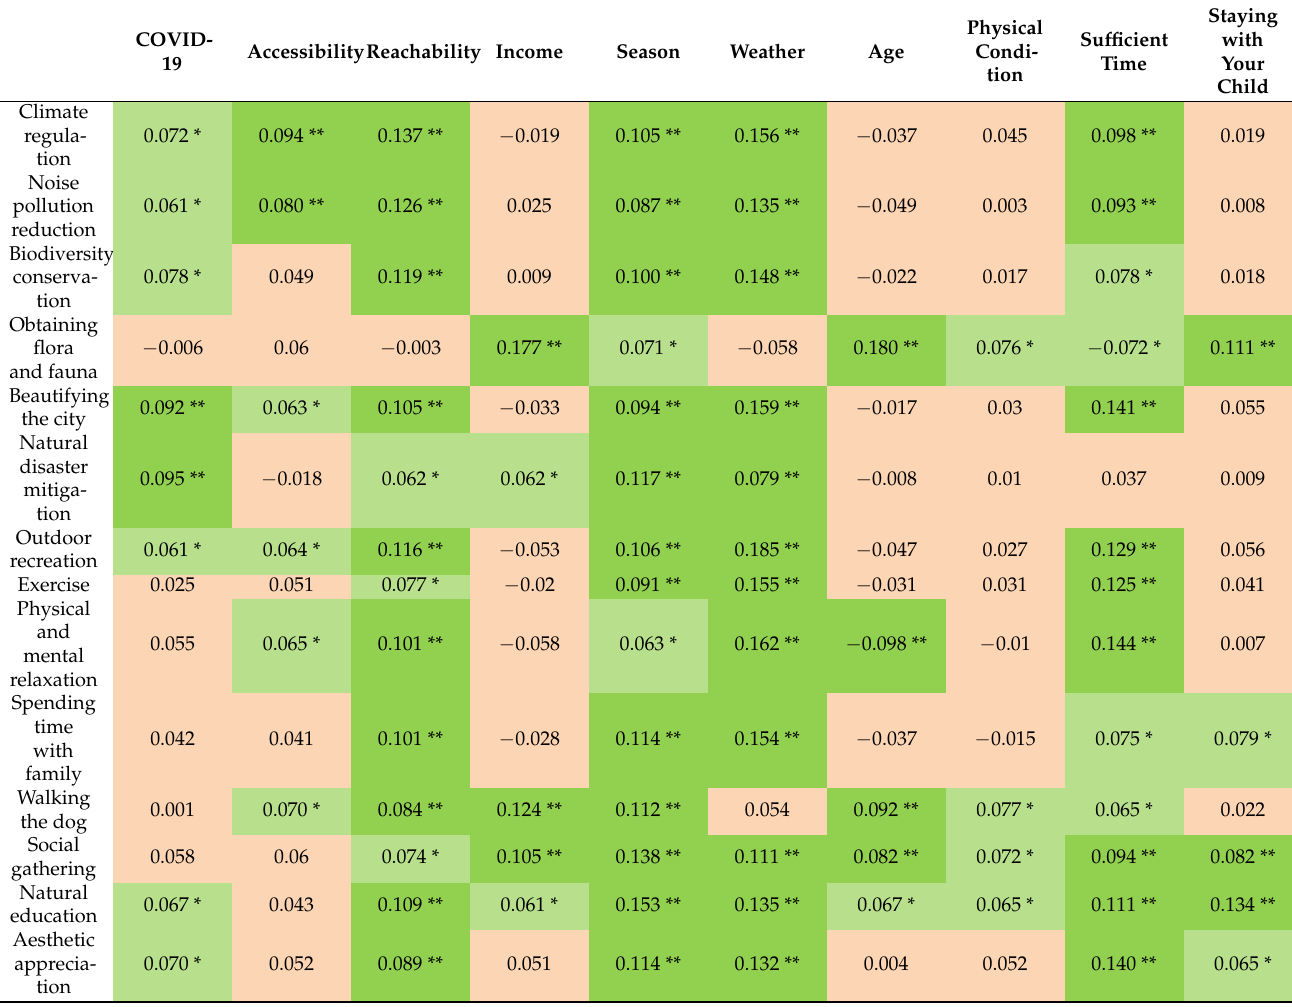
Table 3. Factors affecting the ecological and social services. Orange means no correlation, green means correlation, and, the darker the green, the greater the correlation. *, p < 0.05; **, p < 0.01.